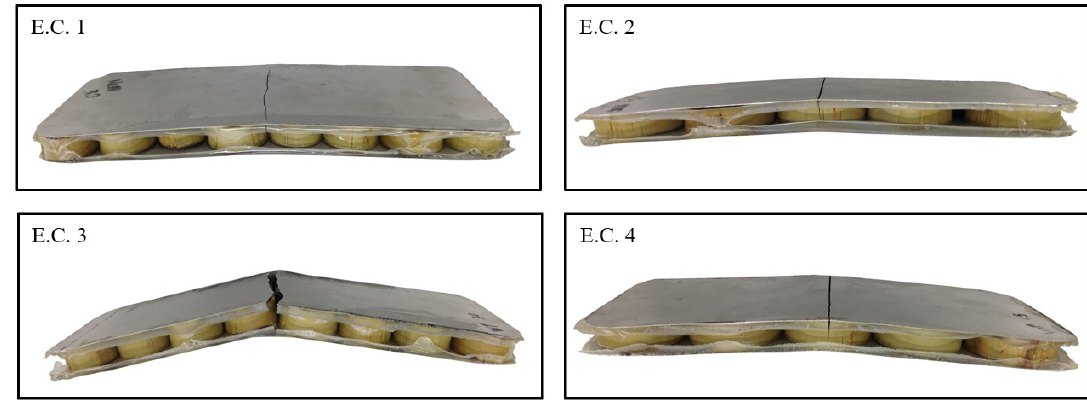
Figure 14. Failure mode of the sandwich panels for each experimental